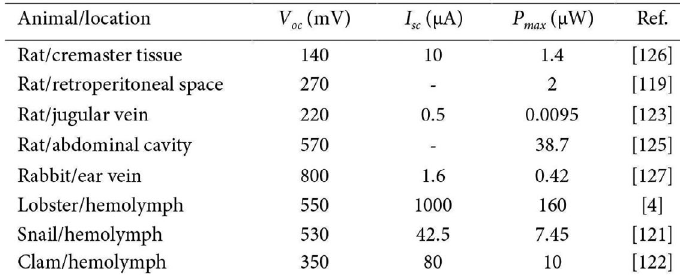
a The numbers given in the table were derived from the original published values taking into account the electrode geometrical areas. For some biofuel cells the electrode areas were not reported, thus current and power cannot be derived from the published values of the current density and power